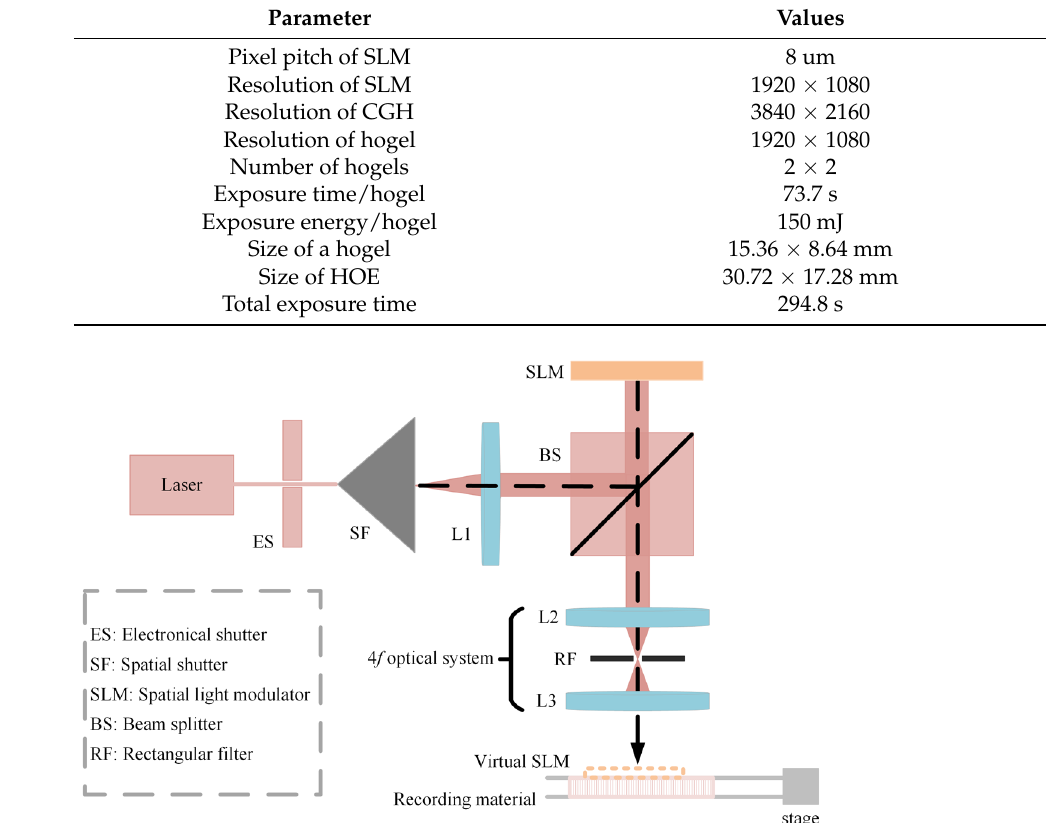
Table 3. The parameters of the printing HOE.